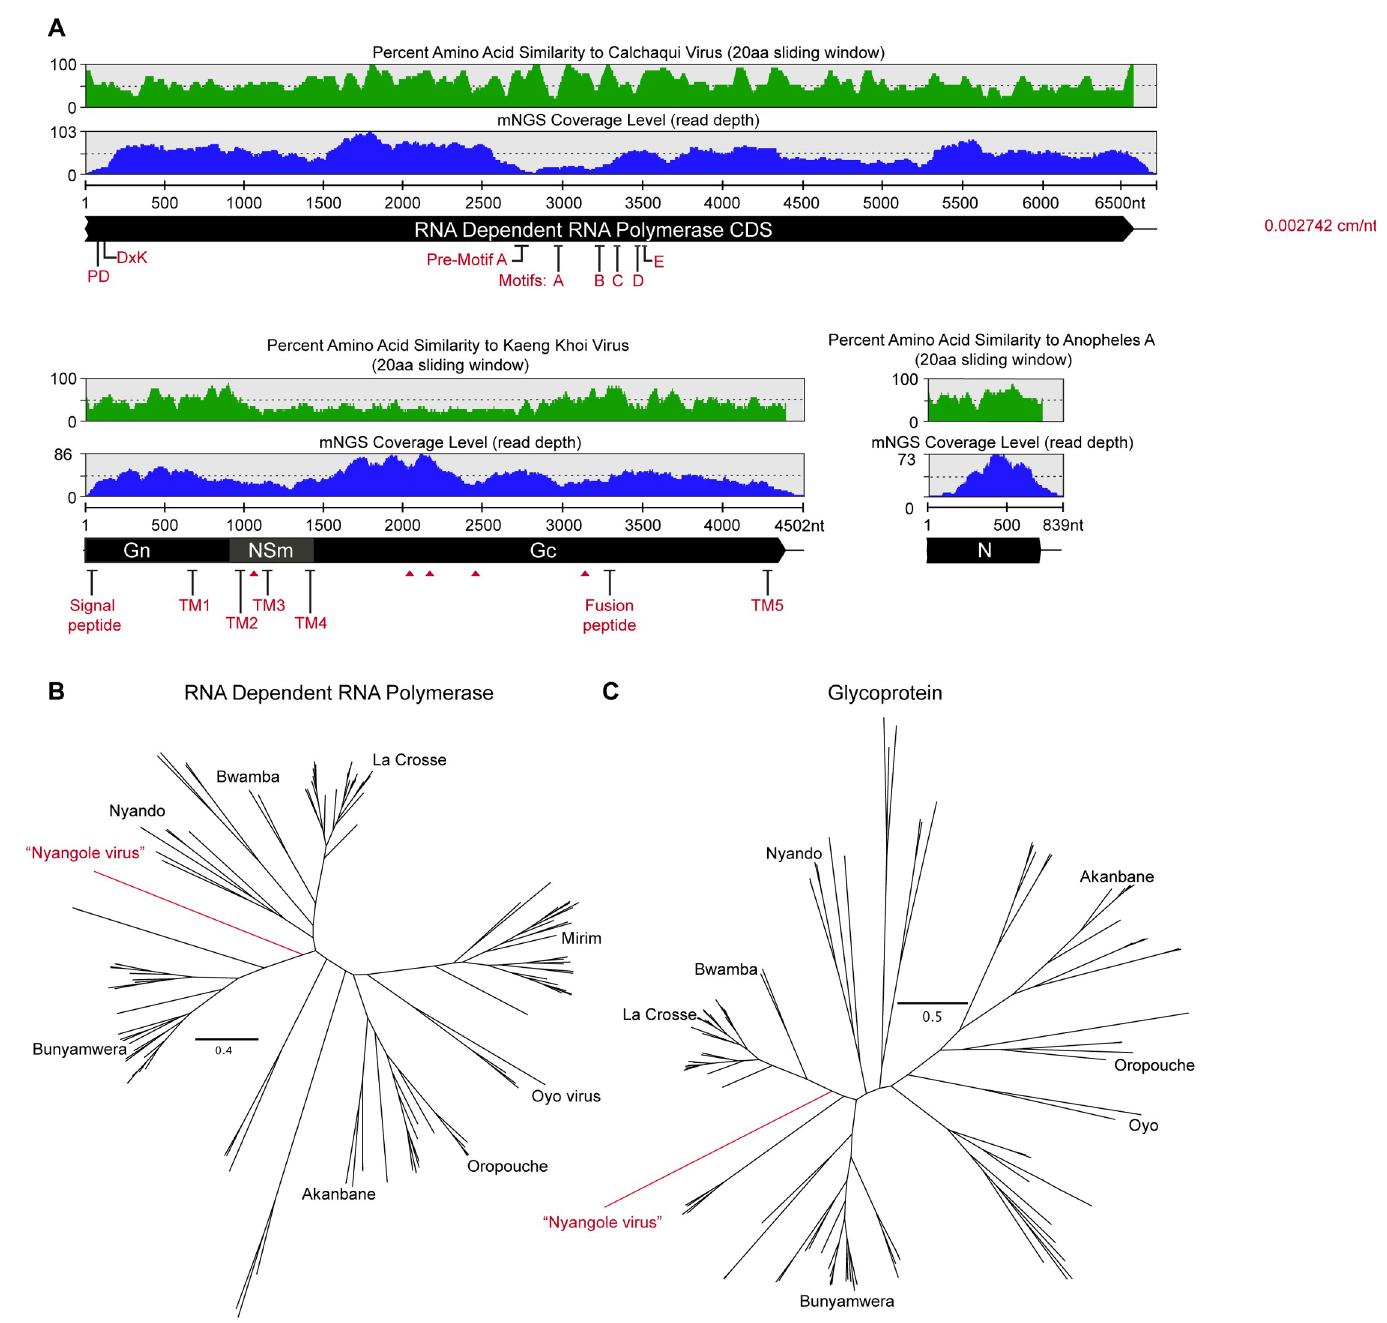
Fig 2. Characterization of the novel orthobunyavirus identified in a febrile child. (A) Schematic representation of the large (L) or RNA dependent RNA polymerase, medium (M) or polyprotein of Gn, NSm and Gc proteins and small (S) segment encoding the nucleocapsid (N) protein of Nyangole virus and percentage identity with the most closely related virus. Phylogenetic tree of all complete orthobunyavirus genome sequences along with Nyangole virus are represented in (B) for the RNA dependent RNA polymerase and (C) for the glycoprotein.